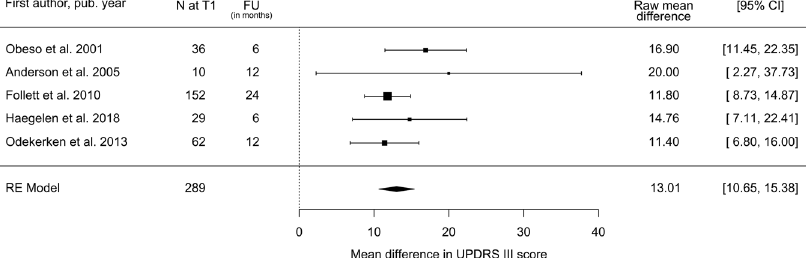
Fig. 5 Estimated decrease in total UPDRS-III score following GPi-DBS. Postoperative stimulation-ON/medication-OFF vs. preoperative OFF- medication state: UPDRS III Mean Difference. N = number of subjects at follow-up; FU = follow-up time; CI = con fi dence interval; RE Model = random-effects model.